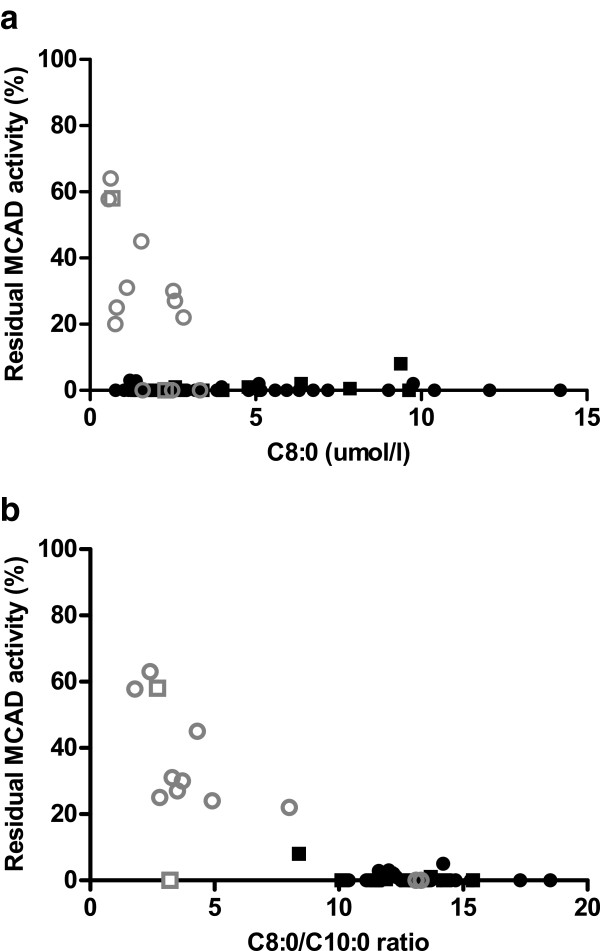
Relationship between residual MCAD enzyme activity and C8:0 and C8:0/C10:0 ratio upon NBS. Legend: Classical ACADM genotypes depicted in black, variant ACADM genotypes in grey. Squares: measured in leukocytes; Circles: measured in lymphocytes.